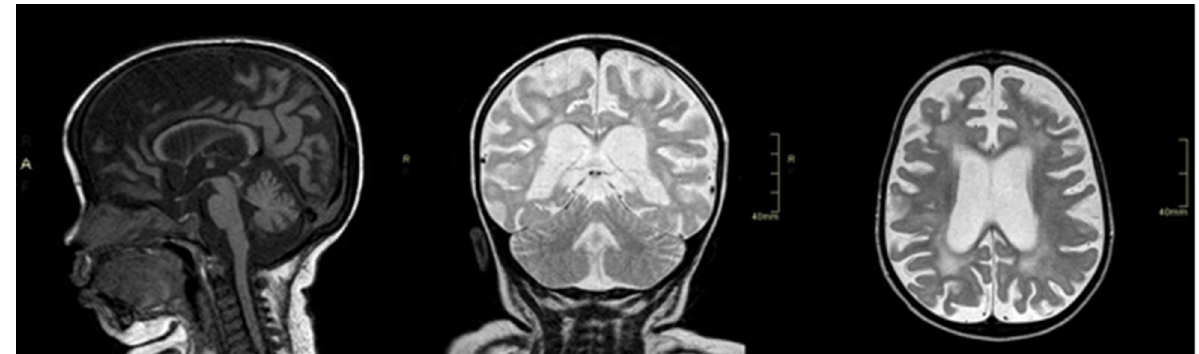
Figure 1. From left to right: sagittal T1 image (cortical-subcortical and corpus callosum atrophy), coronal T2 image (cortical-subcortical atrophy and hyperintensity T2 white matter), axial T2 image (cortical-subcortical atrophy and hyperintensity T2 white matter).